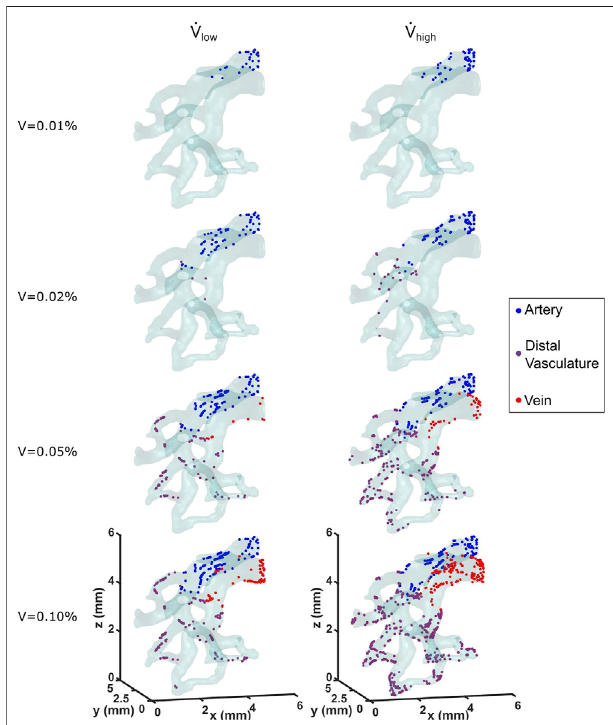
algorithm was used here, with an inertia coef fi cient of C = 300.